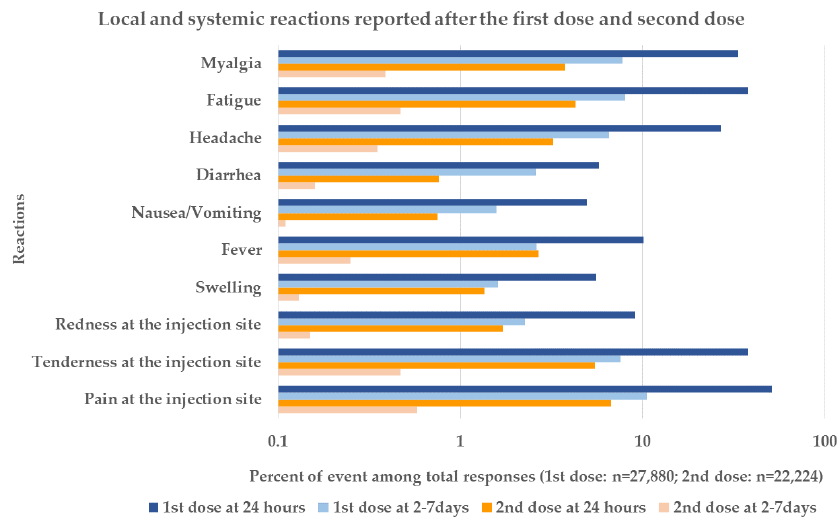
Figure 2. Comparison of the local and systemic reactions reported within the first 24 h and days 2–7 of the first and second dose of BBIBP-CorV in participants aged 10–17 years. Between days 7 and 30 after receiving the second dose of BBIBP-CorV, 83 (0.37%) of 22,224 participants reported local and systemic reactogenicity. The majority of reactions were mild in severity (Figure 1e).